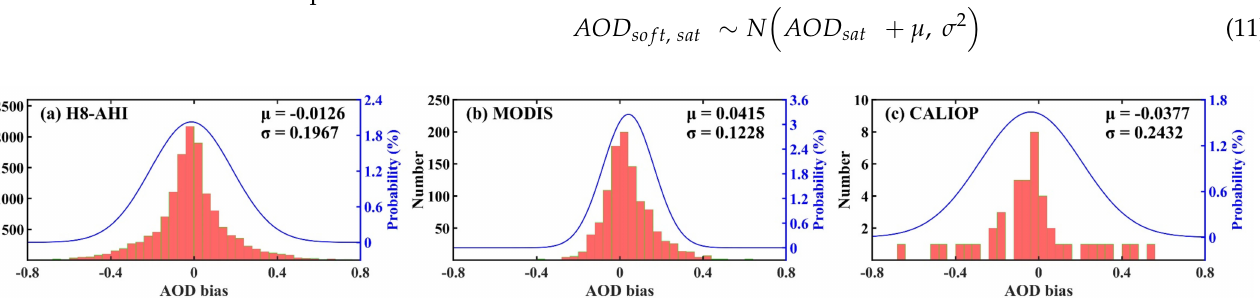
Figure 3. Gaussian probability density functions of the random discrepancy between ( a ) Himawari-8 AHI AODs, ( b ) MODIS AODs, and ( c ) CALIOP and AERONET AODs.